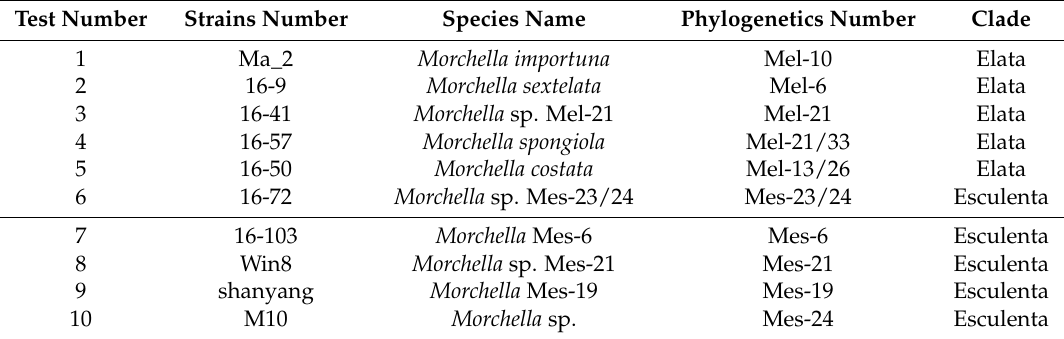
Figure 2. Validation of generality of the selected reference genes in different Morchella species. The order of the phylogenetic name of the species indicated as lanes 1–5 represent Mel-10, Mel-6, Mel-21, Mel-21/33 and Mel-13/26 belonging to Elata clade, while Lanes 6-10 represent Mes-23/24, Mes-6, Mes-21, Mes-19 and Mes-24 belonging to Esculenta clade. Selected reference genes: ( a ) ACT1; ( b ) ATU1; ( c ) AEF3; ( d ) CYC3; ( e ) INTF2; ( f ) INTF3; ( g ) INTF4; ( h ) INTF7; The gels of different batches were separated by the white dotted line.